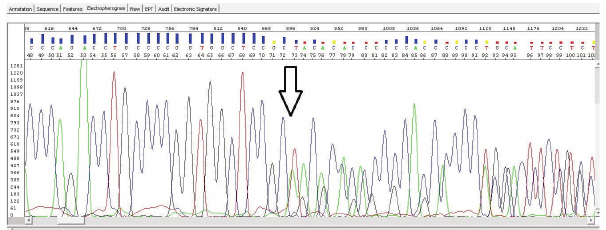
Figure 4: Proband exon 3 homozygous del TACACCC site.